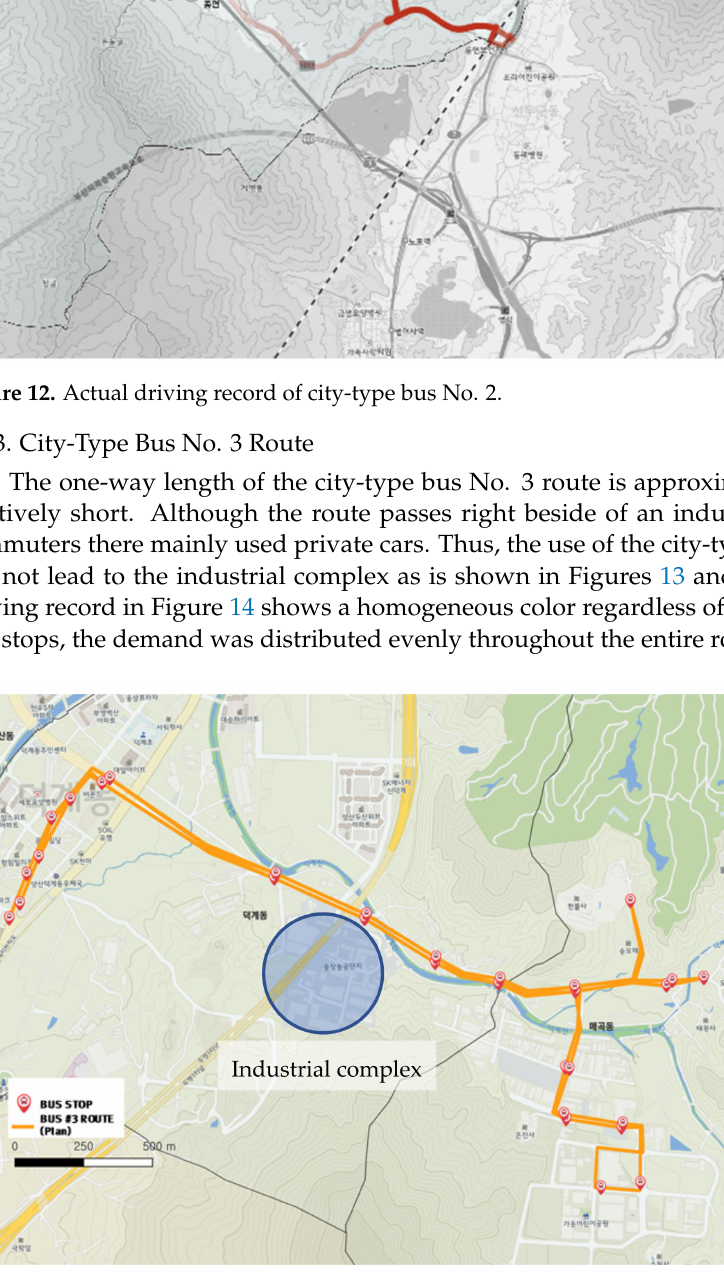
Figure 13. City-type bus No. 3 route (industrial area